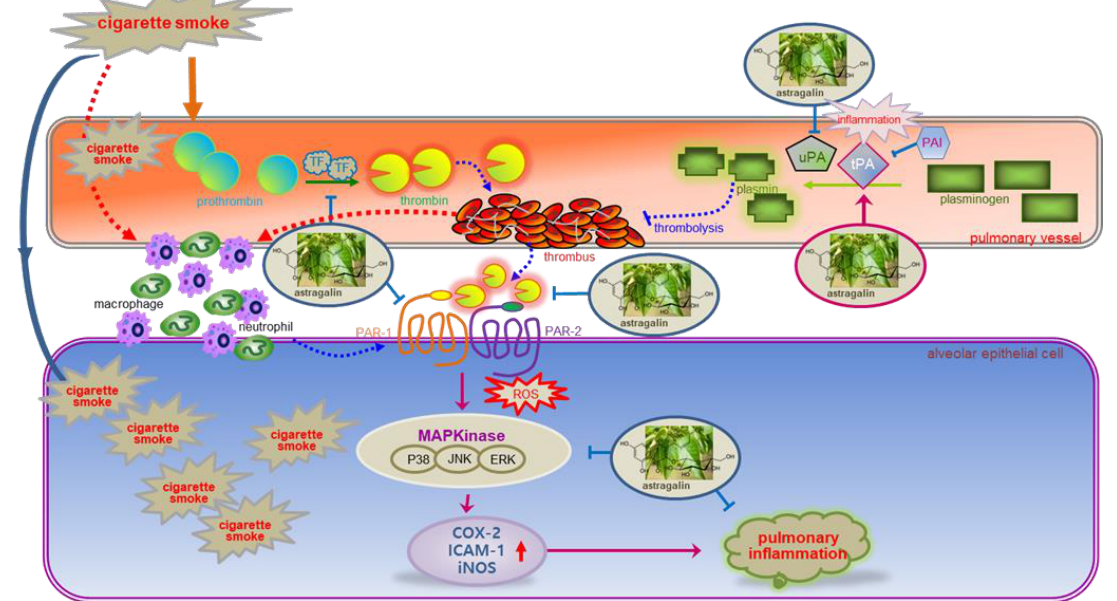
Figure 8. Schematic diagram showing the inhibitory effects of astragalin on astragalin may inhibit pulmonary thrombus-derived inflammation involving PAR-triggered oxidative stress-MAPK signaling. As depicted, astragalin attenuated thrombus formation and pulmonary inflammation. The symbol ⱶ indicates sites of inhibition manifested by astragalin, and the symbol → indicates activation.